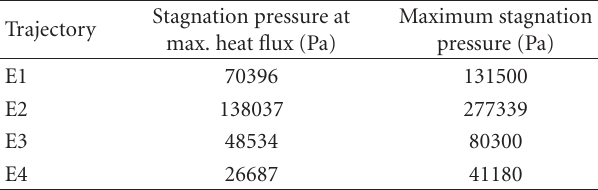
Table 4: Maximum stagnation pressures for an EVD mission [6]. Trajectory